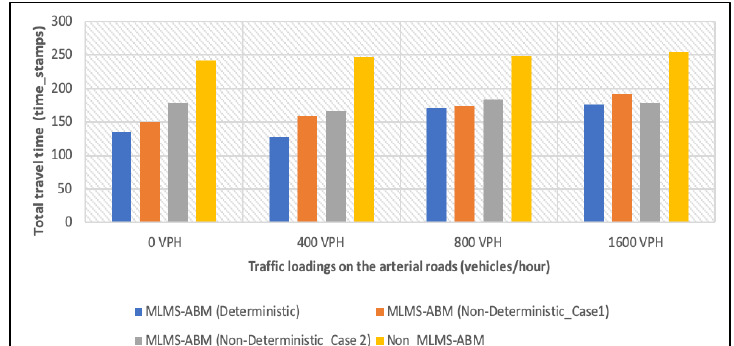
Figure 7. Total travel time for rerouting around accident with different arterial loads.